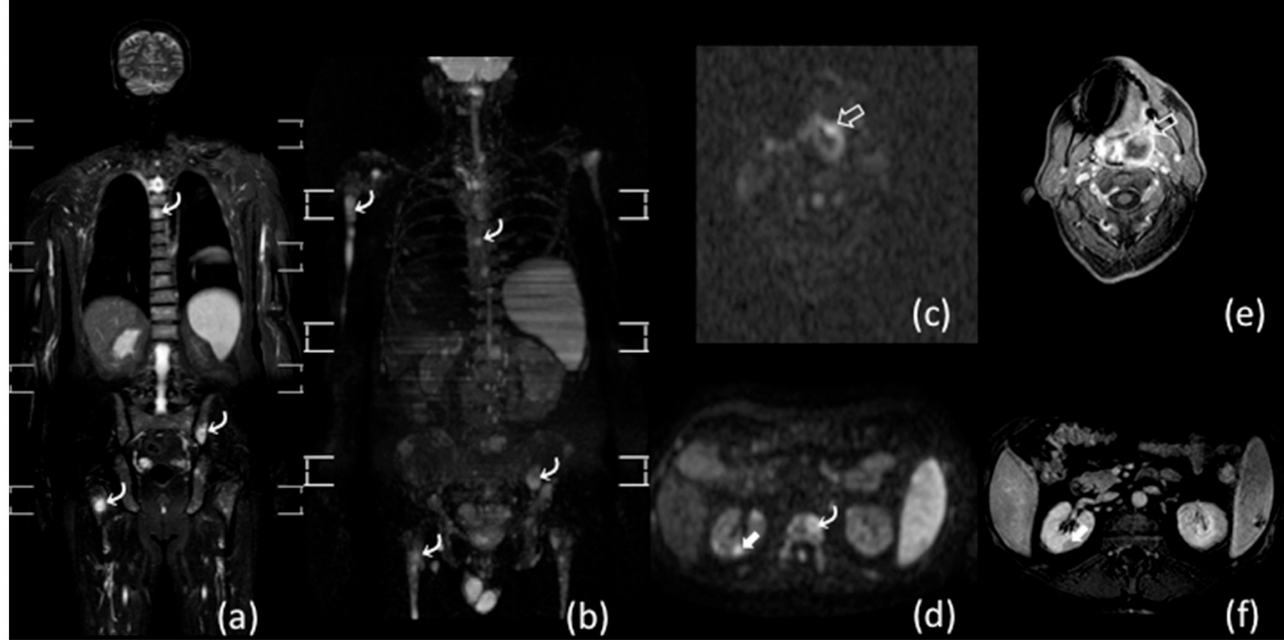
Figure 2. Whole-body MRI of a 65-year-old man with peripheral T-cell lymphoma. Coronal short tau inversion recovery (STIR) ( a ), maximum intensity projection (MIP) b 800 diffusion-weighted imaging (DWI) ( b ), axial b 800 DWI ( c , d ), and axial 3D GRE T1 weighted images after intravenous contrast media injection ( e , f ) show multiple extranodal locations in the left palatine tonsil (void arrows in ( c , e )), in the right kidney (white arrows in ( d , f )) and in the bone marrow (curved arrows in ( a , b , d